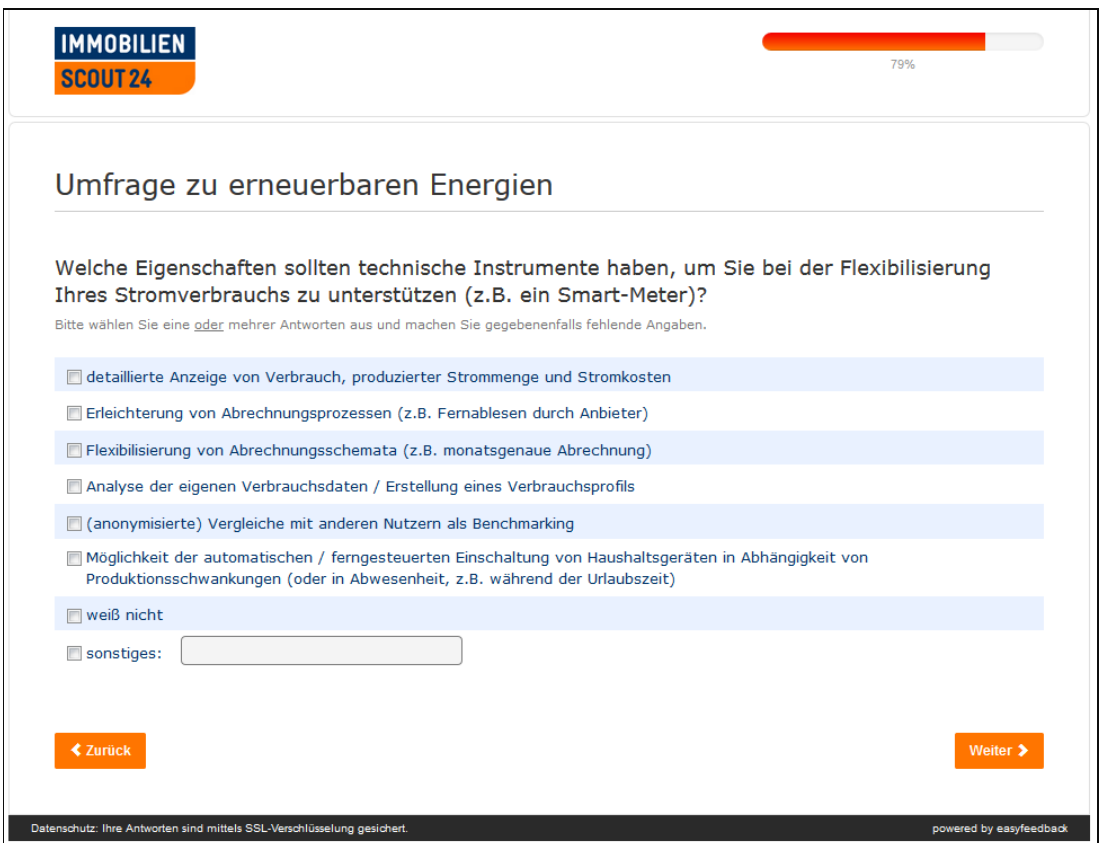
Figure A15. Screenshot of Questionnaire Page 14.